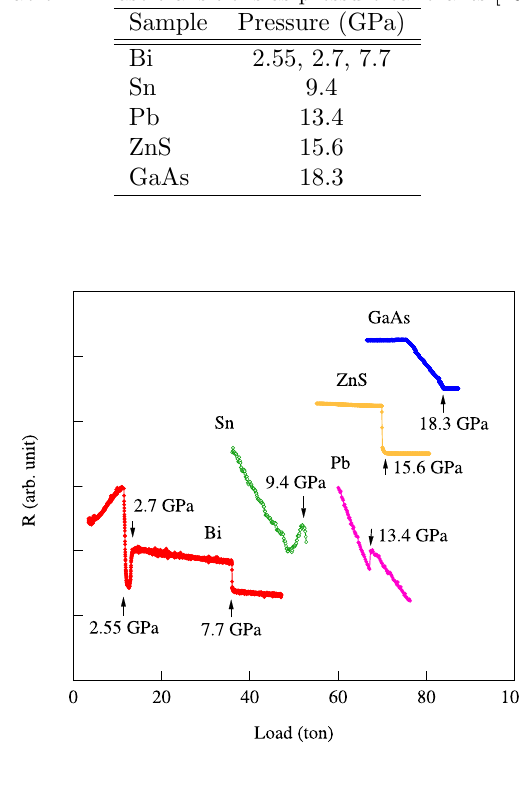
Figure 4: Electrical Resistance of Bi, Sn, Pb, ZnS and GaAs as a function of loading force.